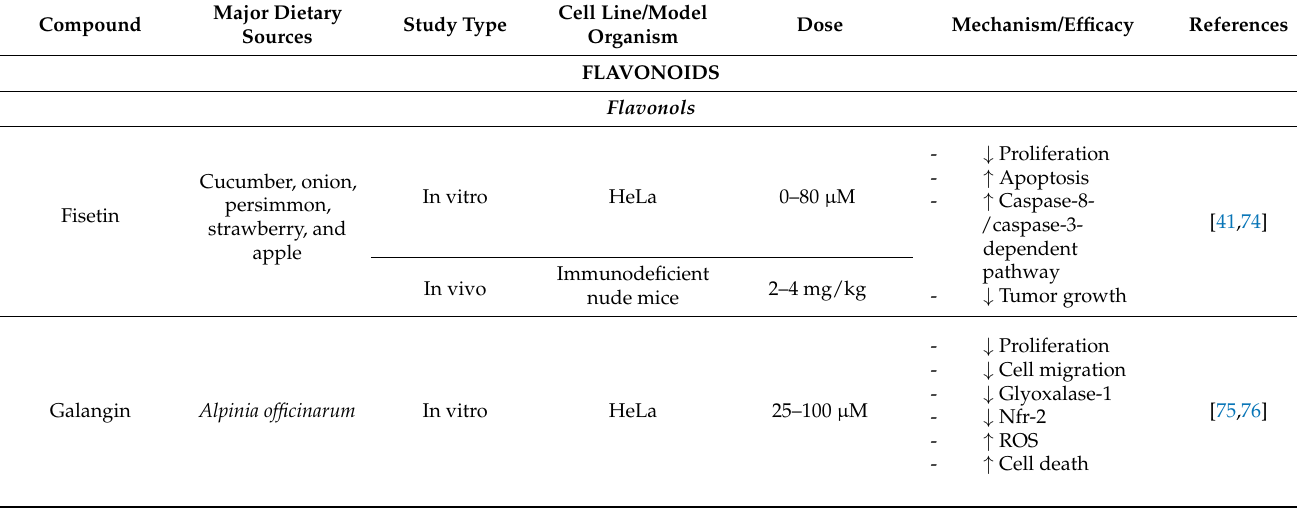
Table 1. Summary of the most used polyphenols in cervical cancer therapy. ↑ indicates upregulation/induction/increasing, while ↓ indicates downregulation/reduction/decreasing.